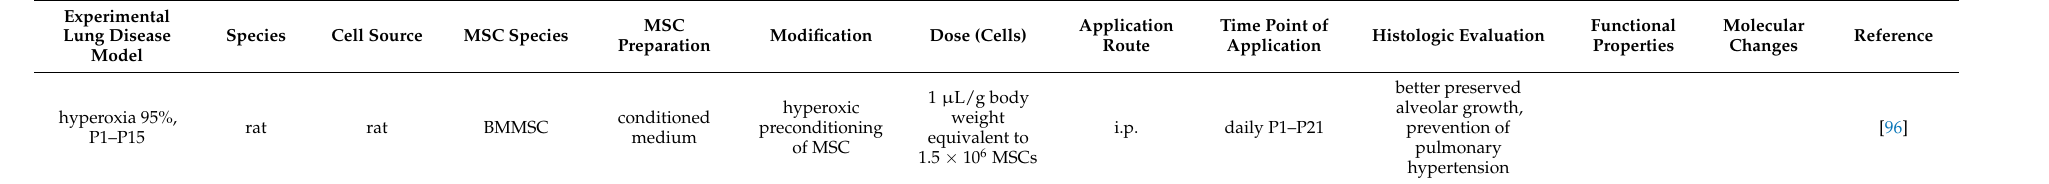
Table 7. Impact of MSC preconditioning on efficacy in the BPD rodent